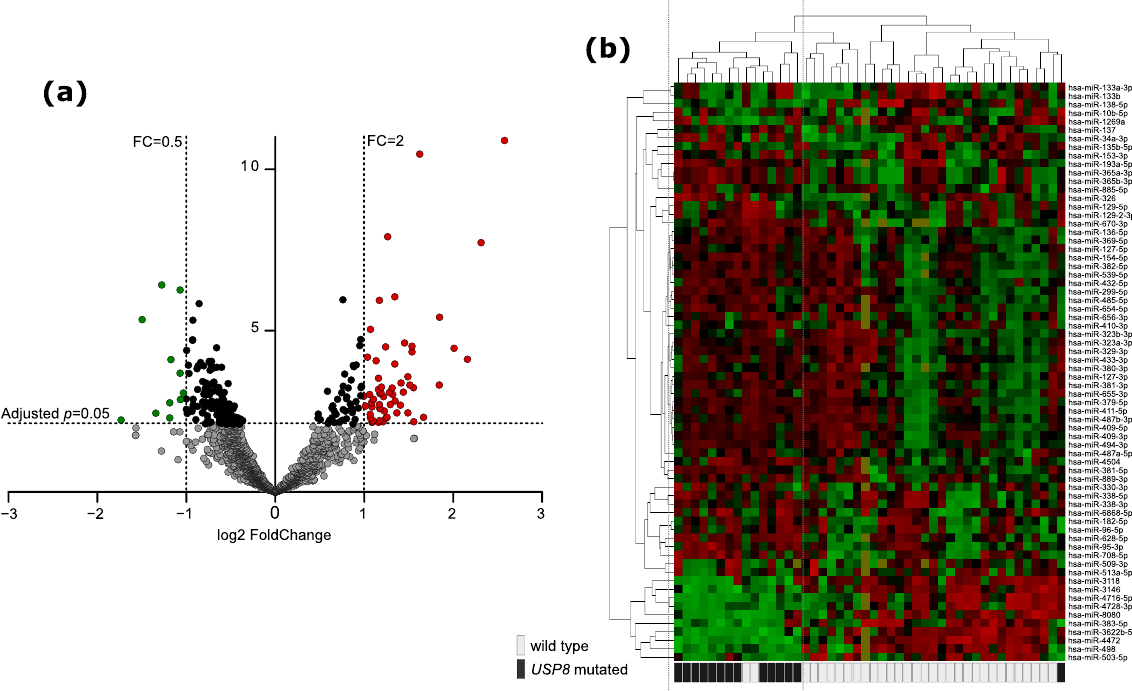
Figure 1. Difference in miRNA expression between USP8 -mutated and USP8 wild-type corticotroph PitNETs. ( a ) Volcano plot showing differentially expressed miRNAs. Significance and fold change thresholds are marked with dashed lines. ( b ) The expression levels of differentially expressed miRNAs in tumor samples stratified according to USP8 mutation status with hierarchical clustering of the